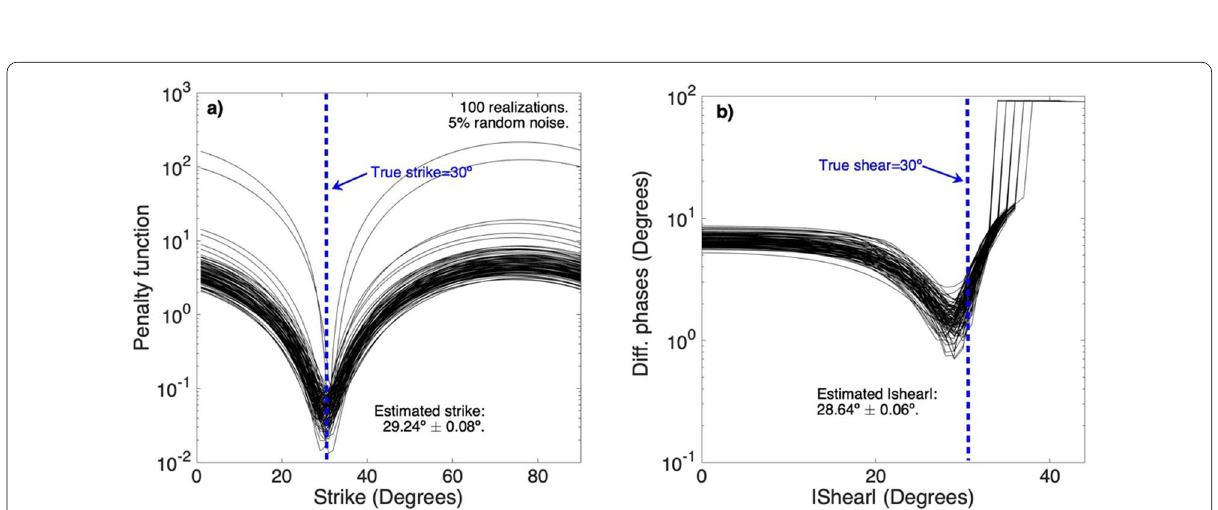
Fig. 8 a Estimation of strike using Eq. (7) for all periods simultaneously. b Estimation of the absolute value of shear comparing the phases from the quadratic equation and the phase